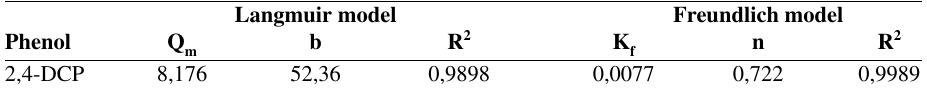
Table 5. Adsorption isotherm constants for 2.4-DCP onto sweetgum bark